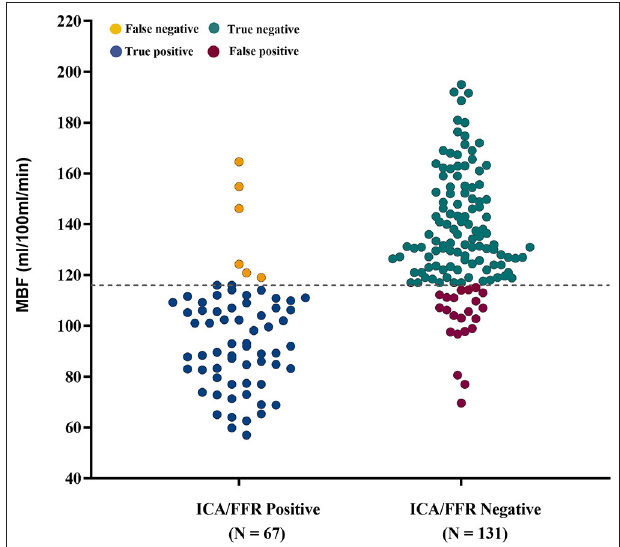
FIGURE 5 | Diagnostic classification by CT-MPI and ICA/FFR. Scatter dot plot of all observations in per-vessel analysis. Gray dashed line represents the cutoff value of MBF of 116 ml/100 ml/min. Yellow dots represent false negatives ( n = 6), blue dots represent true positives ( n = 61), green dots represent true negatives ( n = 109), and red dots represent false positives ( n = 22). FFR, fractional flow reserve; ICA, invasive coronary angiography; MBF, myocardial blood